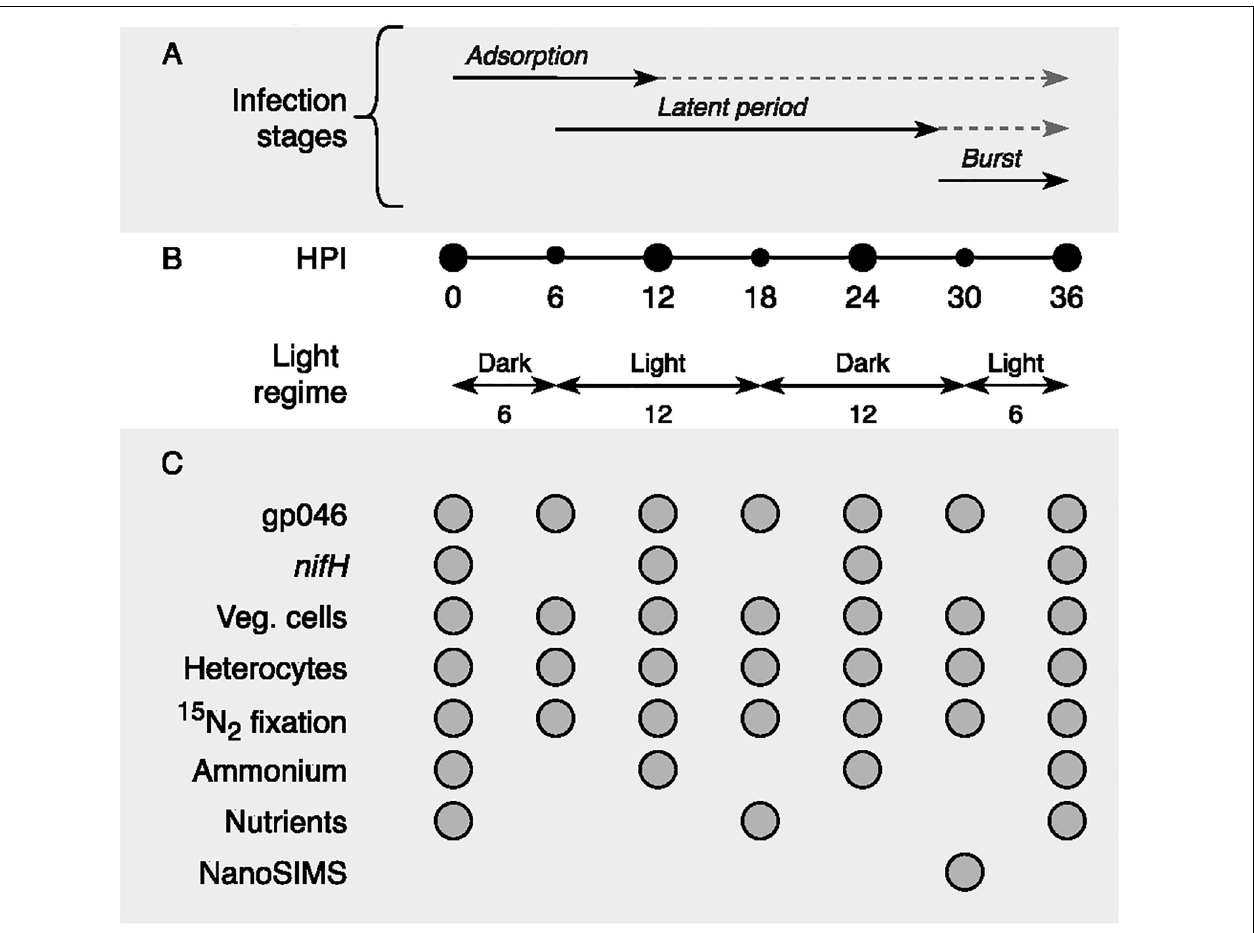
FIGURE 6 | Schematic representation of (A) cyanophage vB_AphaS-CL131 infection stages (adsorption, latent period, and burst; modified from Šulˇcius et al., 2015a), (B) sampling points (black circles) in the context of light regime (hours), and (C) list of measurements taken during the course of the incubation experiment. HPI, hours post inoculation; Veg. cells, vegetative cells. TABLE 1 | Primer sets used for droplet digital PCR analysis of nifH gene expression ( nifH ), DNA contamination in RNA samples (16S) and cyanophage CL131 abundance (gp046). Target